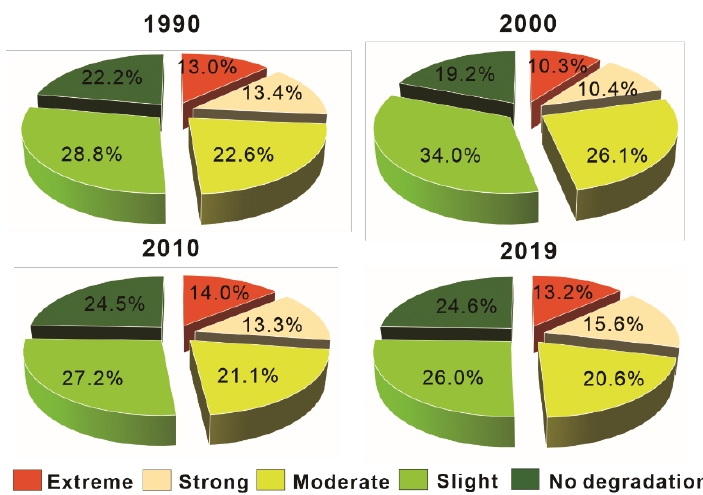
Figure 5. Proportion of land degradation levels in different study years. Extreme: extreme degradation; Strong: strong degradation; Moderate: moderate degradation; Slight: slight degradation.